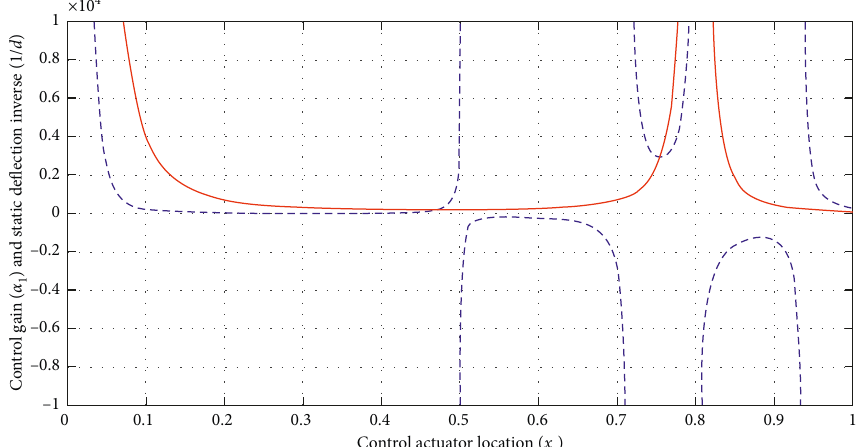
Figure 7: Control gain ( α